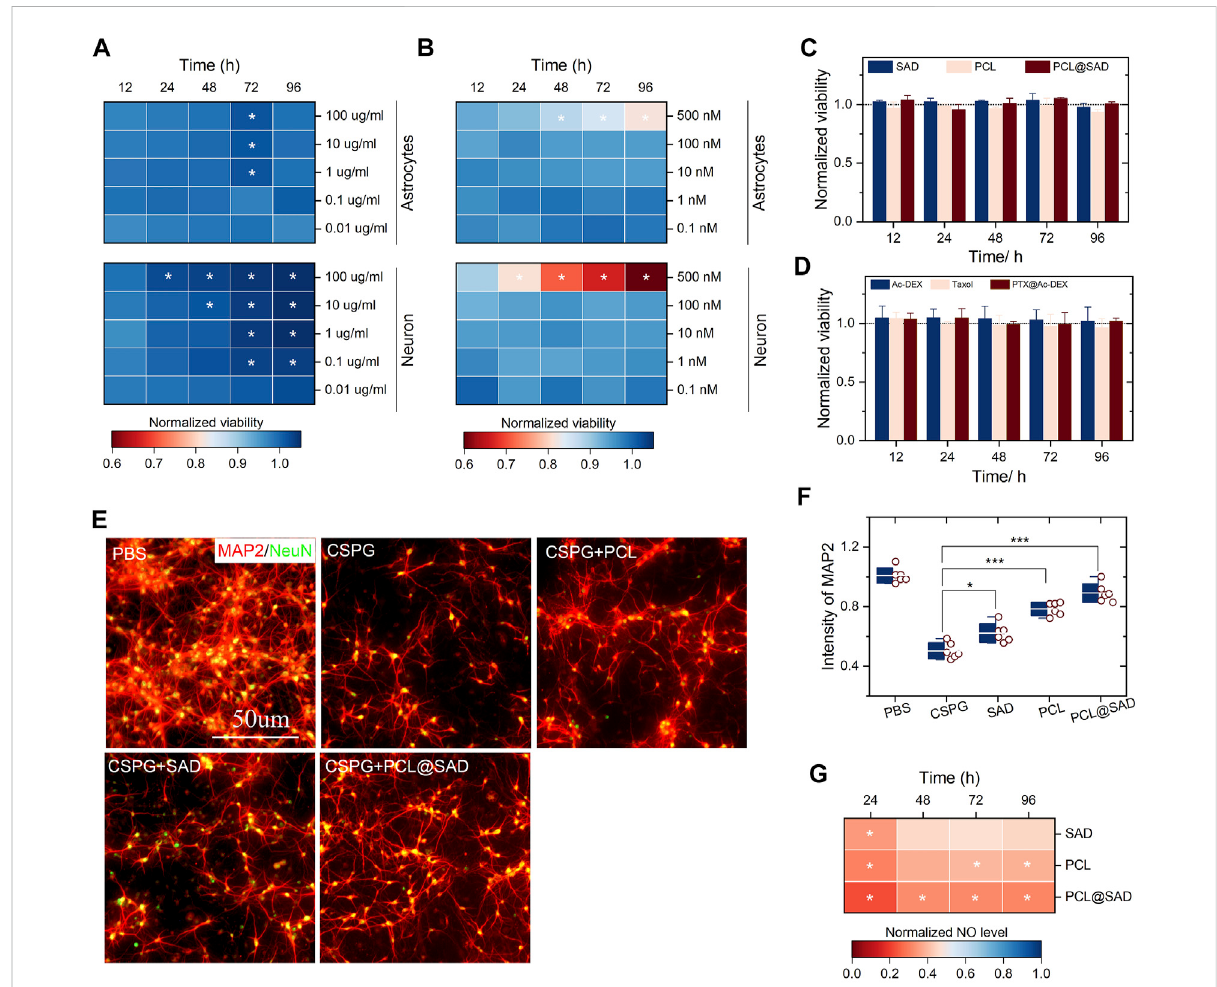
FIGURE 2 Invitro cellviabilityandneuroprotectiveeffectofPCL@SAD. (A,B) TheeffectofSADnanoparticles (A) andPCL (B) ontheneuronalandastrocyte viability ( n = 6). (C,D) SAD nanoparticles, PCL, and PCL@SAD did not affect the viability of astrocyte (C) and neurons (D) ( n = 6). The concentration of PCLwas fi xedat10 nm;theamountofbareSADnanoparticles wasequal tothatofPCL@SAD. (E) Representative imagesofaxonal regenerationwith differentformulationsafterthestimulationwithCSPG.TheconcentrationofPCLwas fi xedat10 nm;theamountofbareSADnanoparticleswas equaltothat ofPCL@SAD. (F) PCL@SAD,PCL,andSADallimprovedtheintensityofMAP2,whencomparedwiththePBSgroup( n =6). (G) Theeffect of PCL@SAD on the release of NO from neurons stimulated by lipopolysaccharide ( n = 6). The concentration of PCL was fi xed at10 nm; the amount of bare SAD nanoparticles was equal to that of PCL@SAD. * p < 0.05, ** p < 0.01, and *** p <